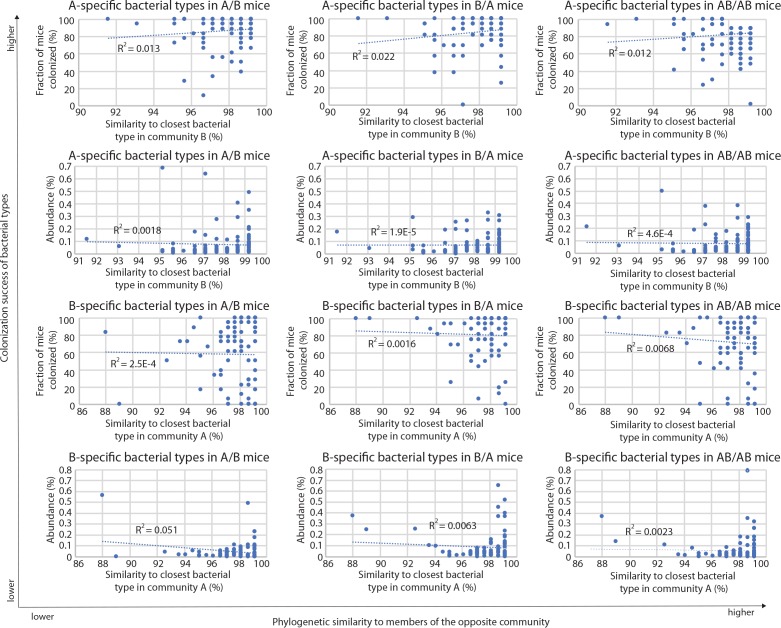
Correlations between A-specific and B-specific types in donor communities and the closest related types in the competing community, in the different groups of mice (A/B, B/A, and AB/AB).R2 values of the corresponding linear regressions are included in each plot.